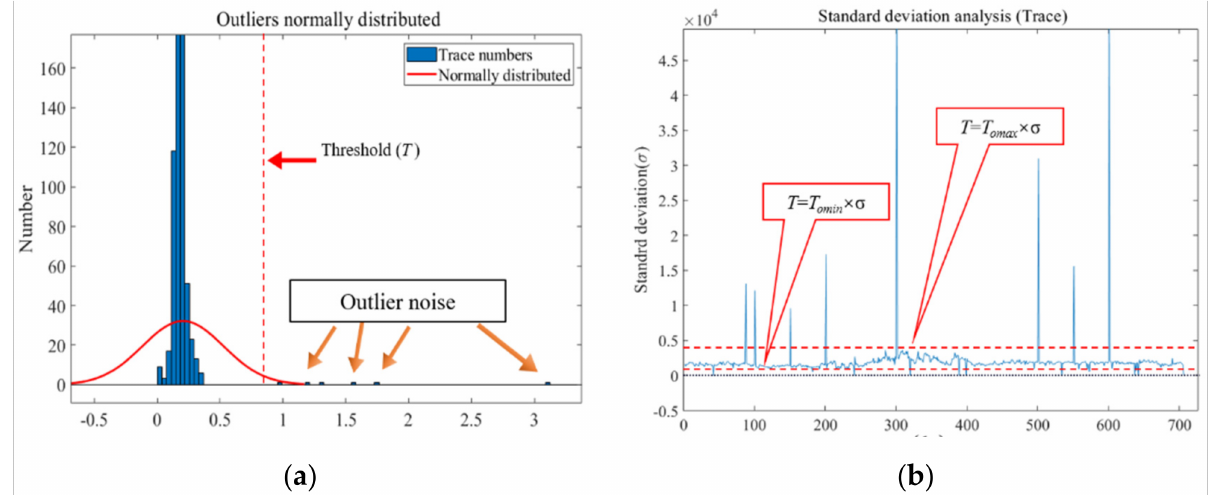
Figure 13. The statistical results of outlier noise for the noisy data. ( a ) Energy distributed analysis. ( b ) Threshold processing